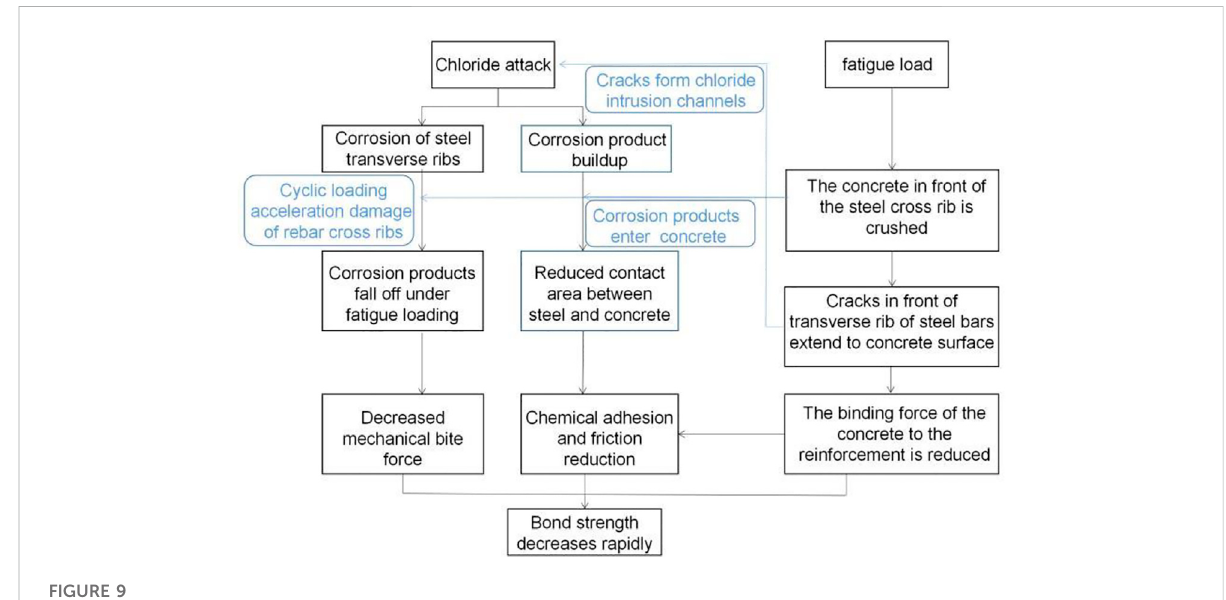
FIGURE 9 Mechanism of combined